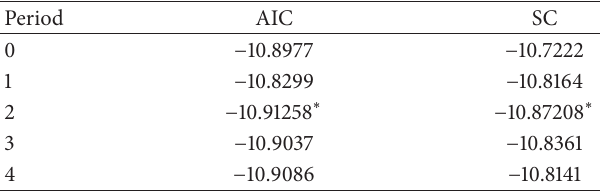
Table 3: The selection of the VAR model optimal lag period.